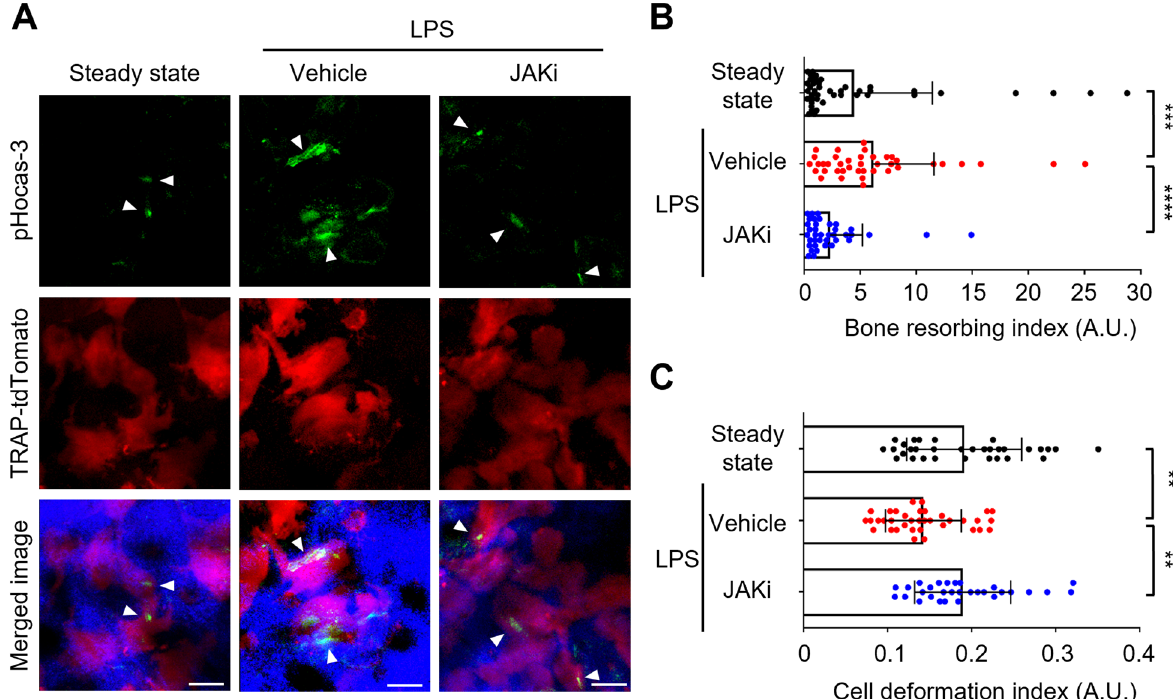
Fig. 1 JAK inhibitor suppressed the function of inflammation-activated mature osteoclasts. A Representative intravital multiphoton imaging results of the bone resorptive activity of mature osteoclasts in calvarial bones in JAK inhibitor (JAKi)-treated LPS-induced mice. Green, pHocas-3; red, TRAP-tdTomato + mature osteoclasts; blue, bones (second harmonic generation). Arrowheads: bone resorption areas. Scale bar, 30 µm. B The bone resorption index (BRI) of mature osteoclasts. A higher BRI indicates increased osteoclast activity (steady state, n 43 images; vehicle, n 40 images; = = JAKi, n 38 images from 5 mice per group). Error bars indicate the means SDs. C Mobility of mature osteoclasts. A higher cell deformation index = + (CDI) indicates increased mobility (steady state, n 32 cells from 3 mice; vehicle, n 36 cells from 3 mice; JAKi, n 30 cells from 4 mice). Error bars = = = indicate the means SDs. Statistical significance was determined by Kruskal-Wallis test. ** P < 0.01, *** P < 0.001 **** P ±